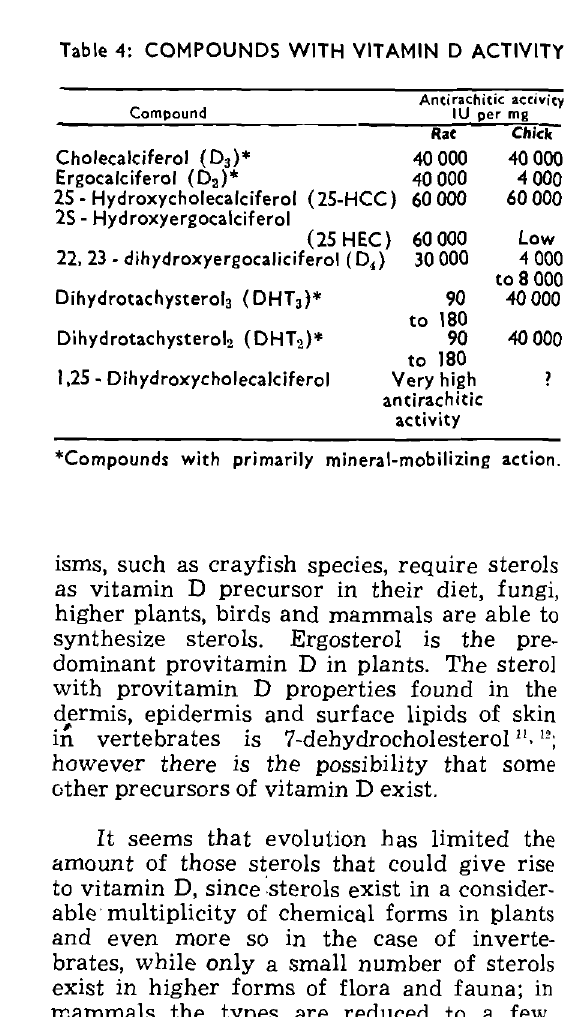
Table 4: COMPOUNDS WITH VITAMIN D